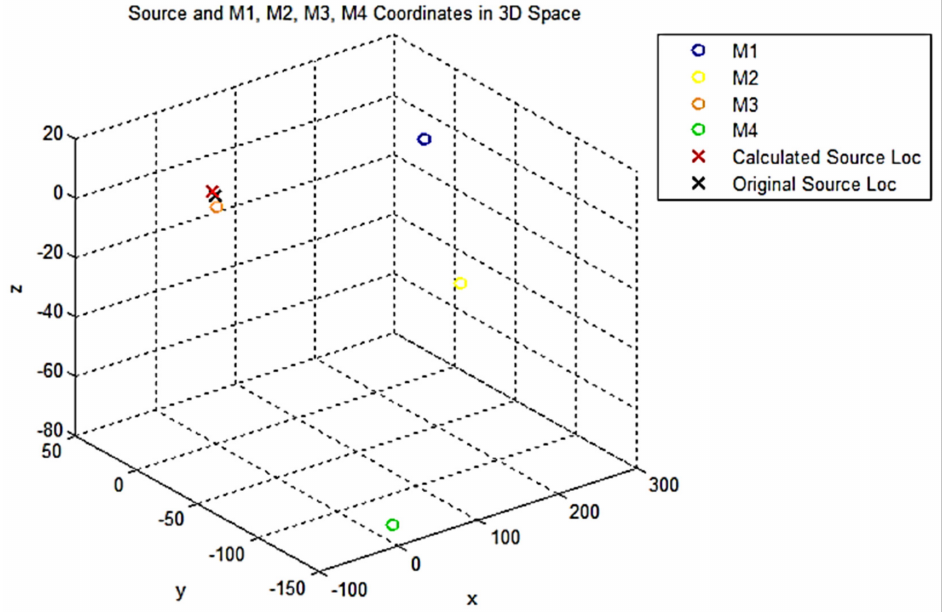
Figure 12. 3D model with source at (30, 100,